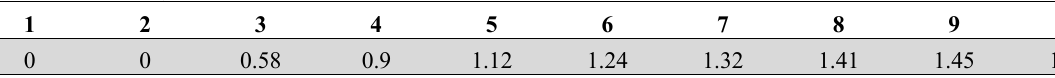
Random Consistency Index Value